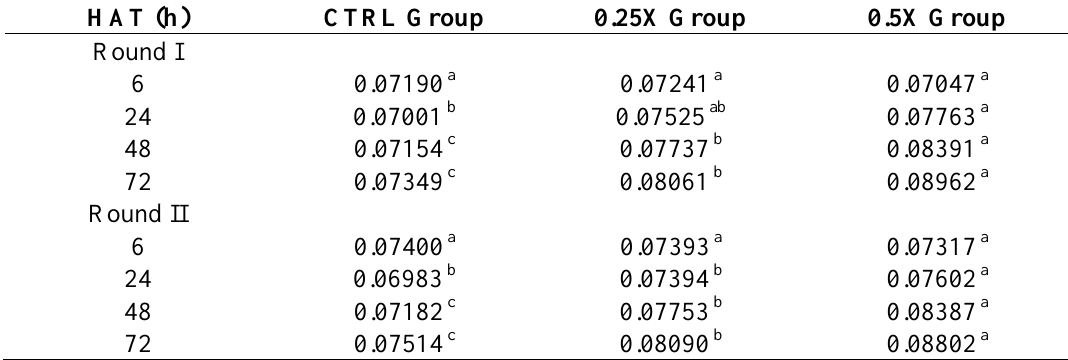
Table 8. Cross validation results for FCA based on Duncan’s multiple range tests * . Each s value is a mean of three soybean leaves for the same group in the validation